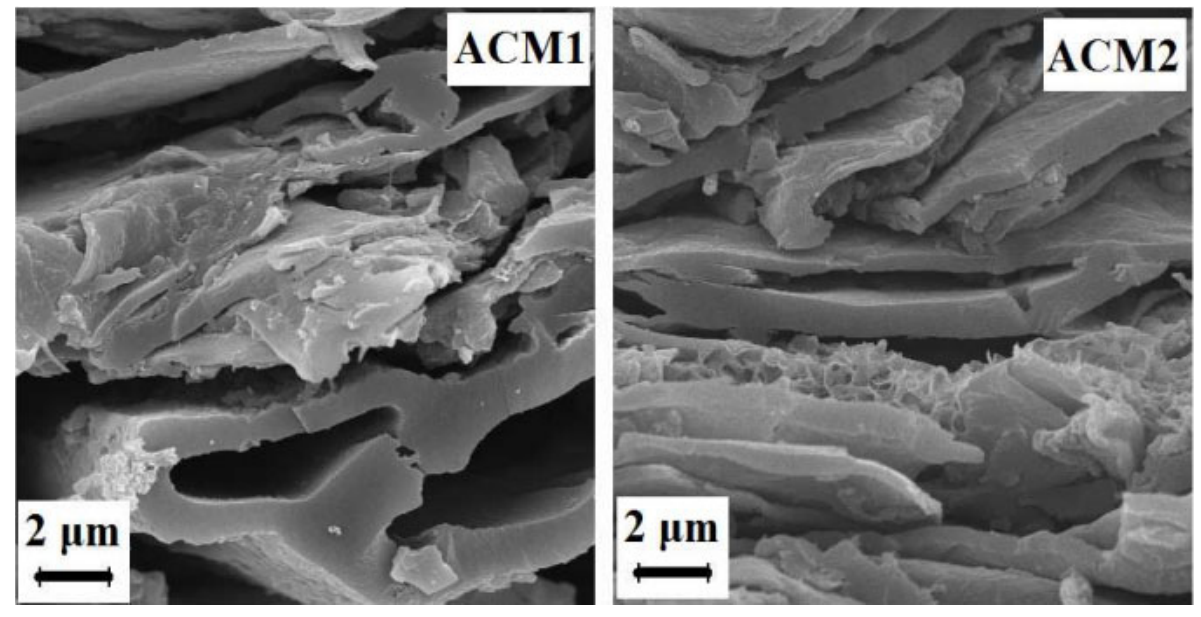
Figure 9. SEM micrographs. ACM1 activated carbon via physical activation, and ACM2 activated carbon via physicochemical activation. Reprinted with permission from Ref. [74]. Copyright © 2022 by Trans Tech Publications Ltd.